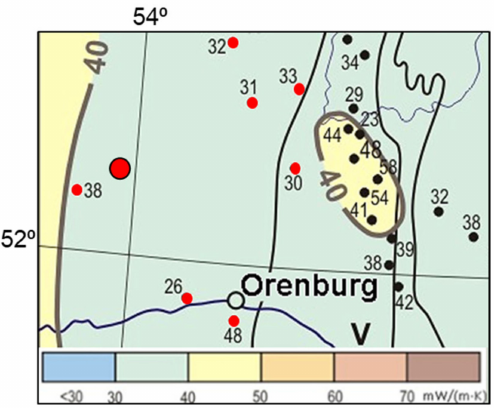
Figure 1. Geographic location of the understudy well on the heat flow map [25]. The large red point indicates the well’s